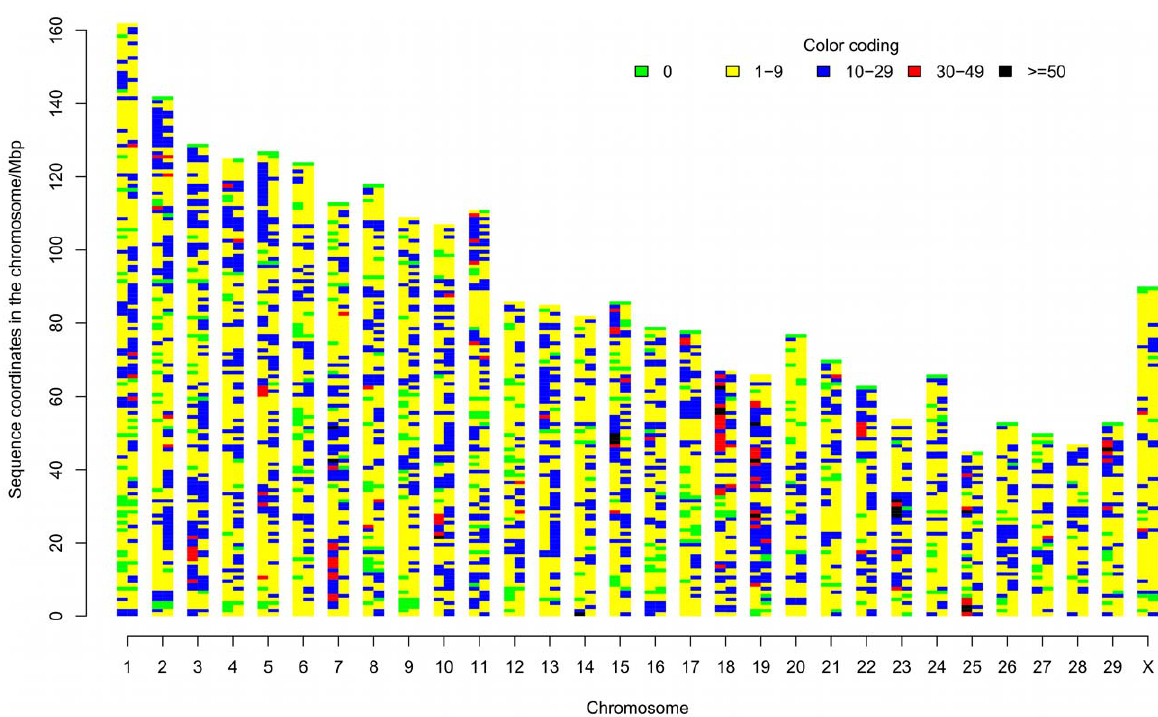
Figure 2. Distribution of genes and ncRNAs in the bovine genome. Chromosomes are on the X axis, and sequence coordinates on the Y axis, with the ‘‘top’’ of the chromosome at the Y axis origin. All cattle autosomes are acrocentric. Each chromosome is represented by two vertical bands, the left band shows gene number and the right band shows ncRNA number, per 1 Mb bin. The legend shows the band colour coding for numbers per 1 Mb bin.